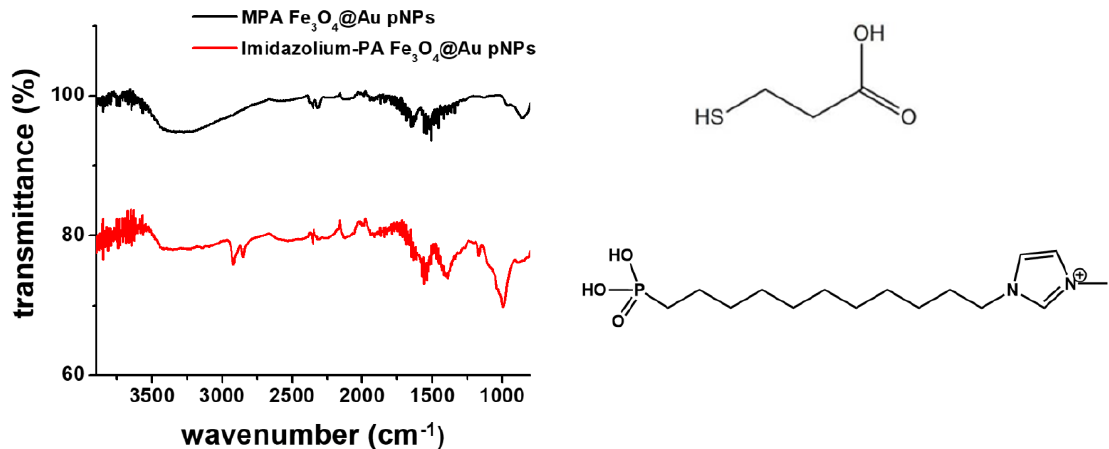
Figure 6. FTIR transmission spectra of the Fe 3 O 4 @Au pNPs and the structure formula of the surfactants MPA ( top right ) and Imidazolium-PA ( bottom right ).